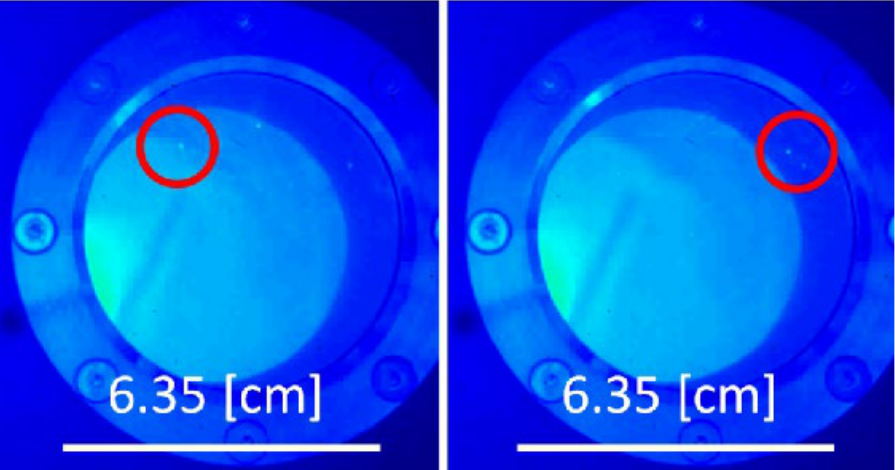
Figure 14. A sample of data collected at consecutive timestamps using the MWIR camera and the particle tracking method. MWIR compatible windows were installed above the free-surface flow. The impurity particle used as a tracer is marked by a red circle [77].